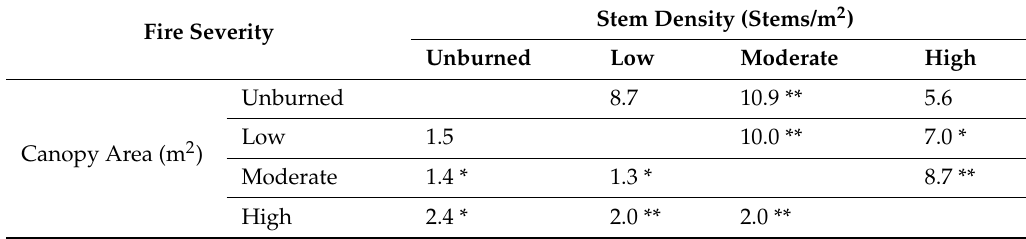
Table 2. Mean shrub patch size and mean stem density across pairwise fire severity comparisons, in the study area.